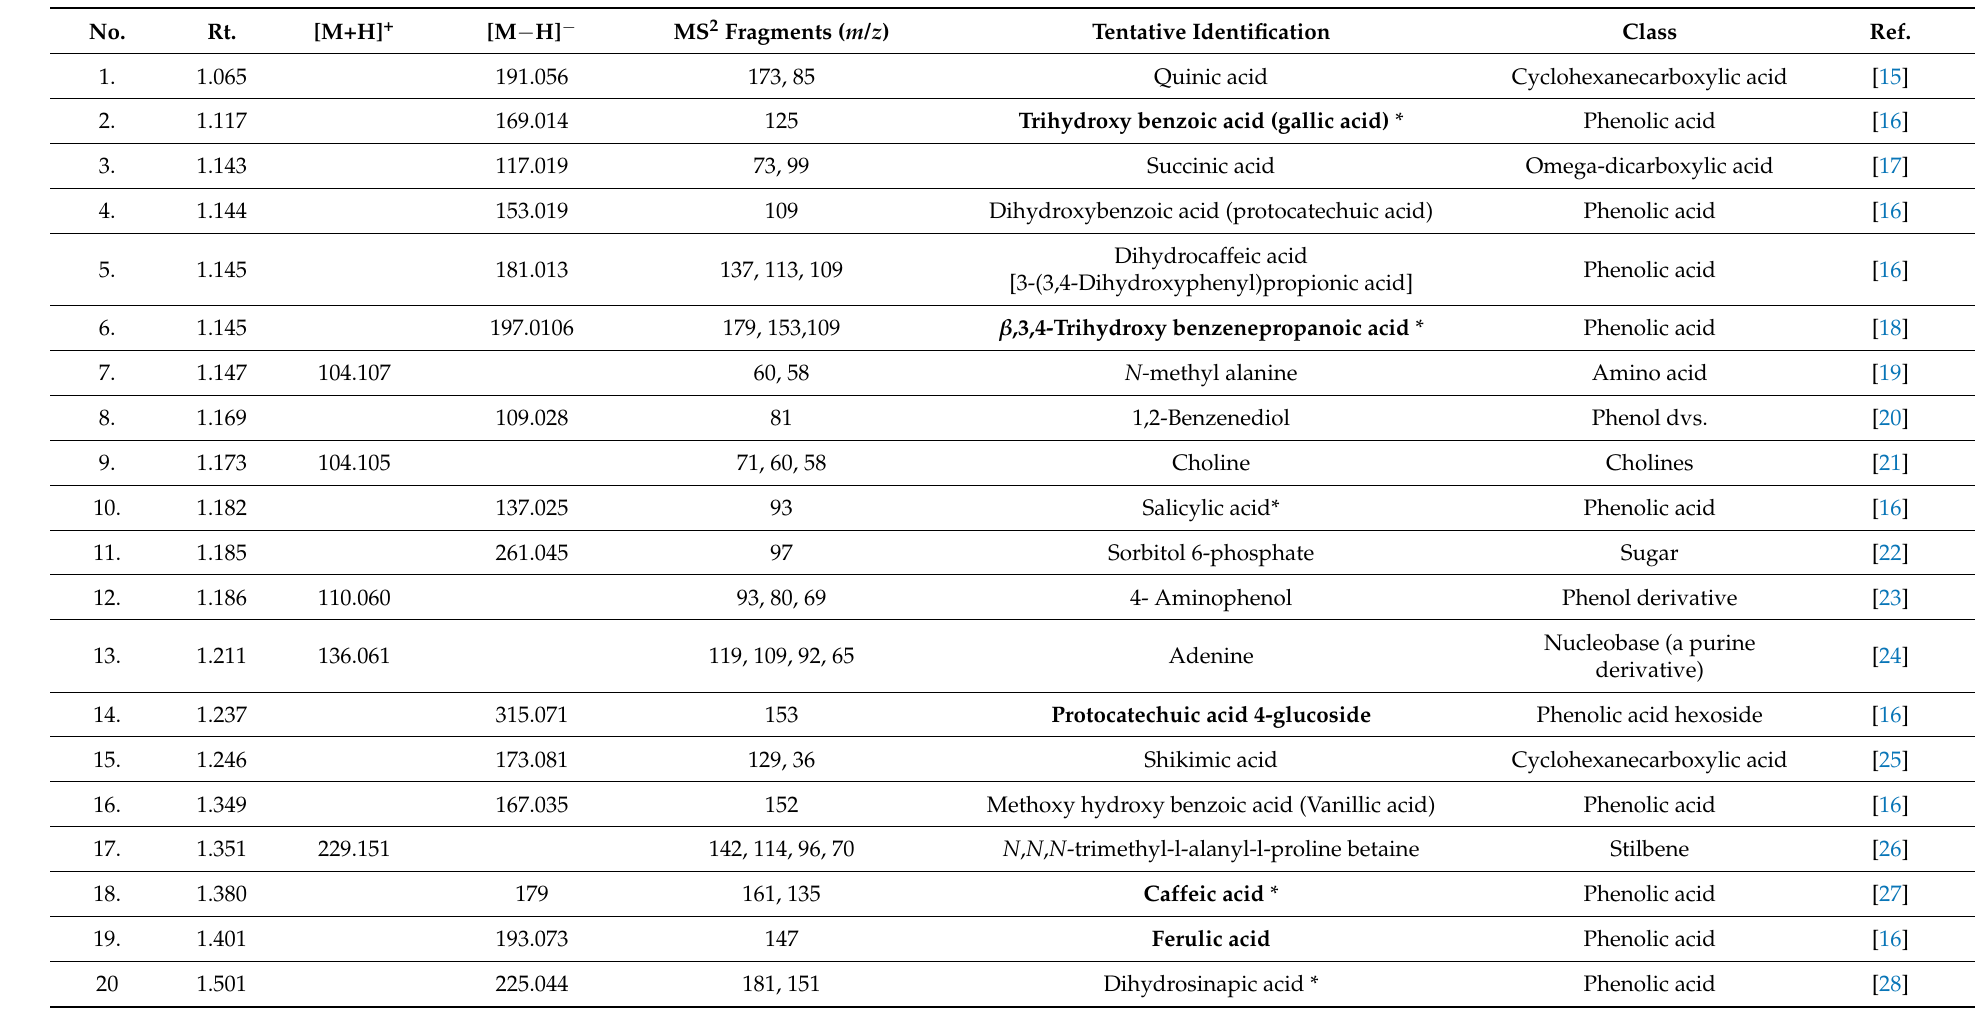
Table 1. Metabolites identified in ARBE using LC-ESI-MS/MS in negative and positive ionization